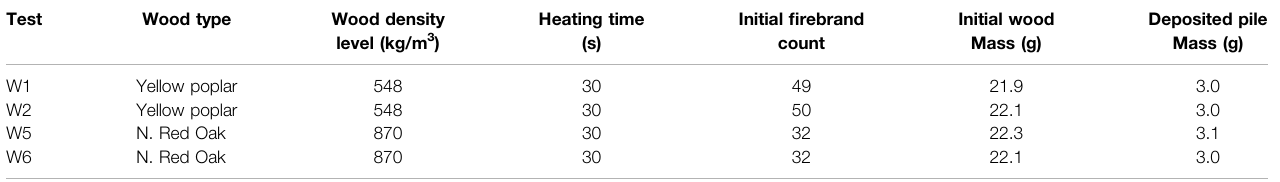
TABLE4| Testmatrixusedtoassesstheimpact of fi rebrandwooddensity factorontheheat fl uxfrom fi rebrandpiles.Firebranddiameter9.5 mm,length12.5 mm,andMC 0% with wind speed 2.0 m/s.